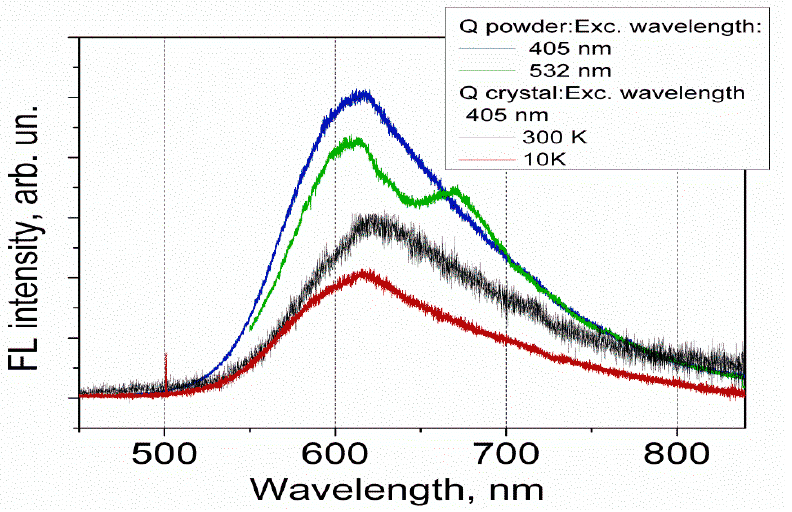
Figure 3. FL emission spectra of Q crystal at 10 K (red curve) and at 300 K (black curve), and FL spectra of Q powder at 300 K measured with two different excitation wavelengths (blue and green curves). To facilitate comparison the spectra are shown in arbitrary units.